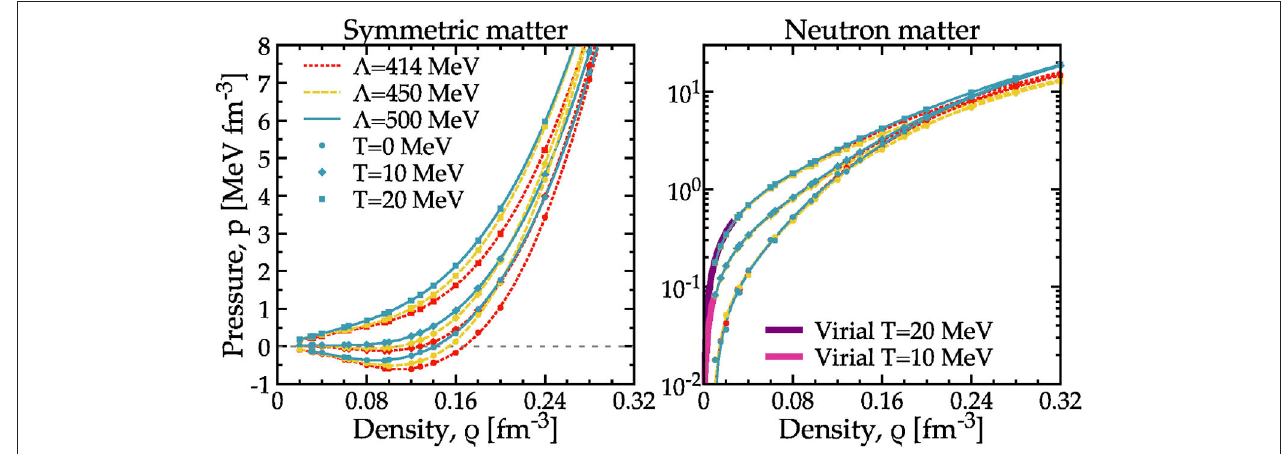
FIGURE 11 | Pressure as a function of density for symmetric nuclear matter (left) and pure neutron matter (right) . Results for three NN interactions are shown at three different temperatures: T = 0 10 and 20 MeV. At low density for neutron matter, the two bands display the results from the virial